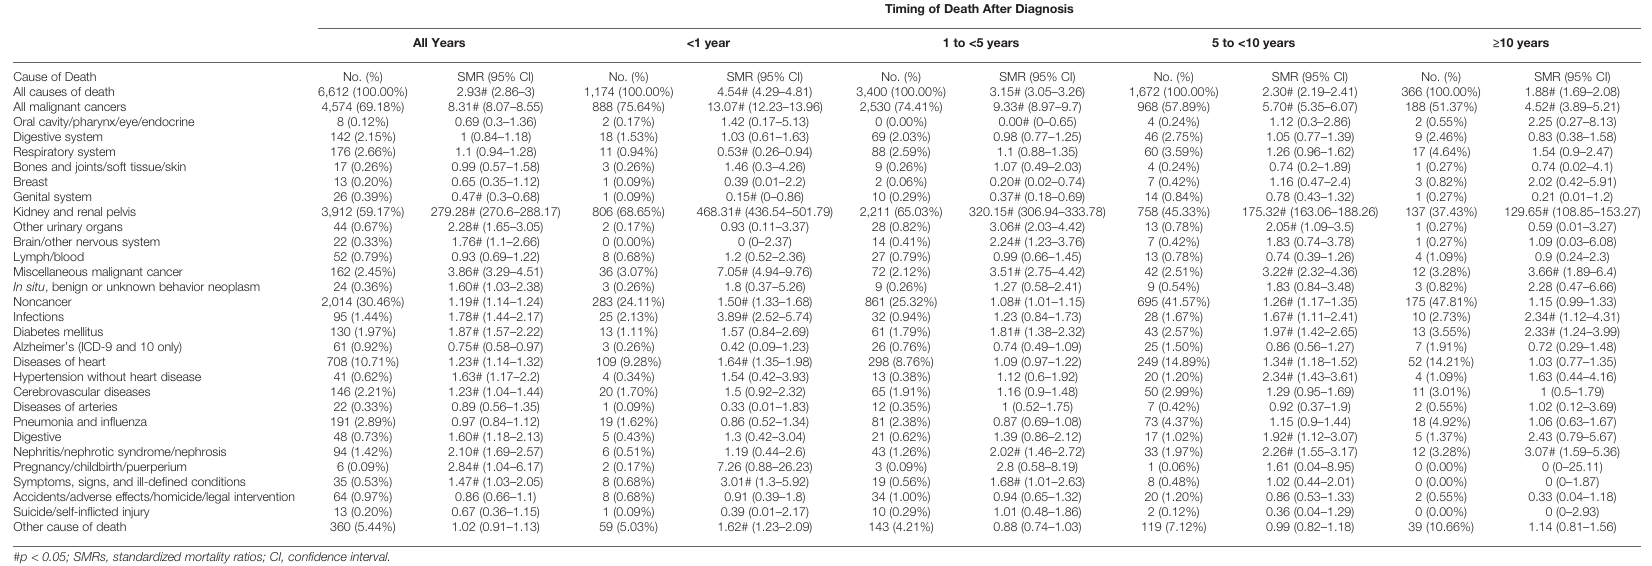
TABLE 3 | Causes of death for patients with stage III RCC.